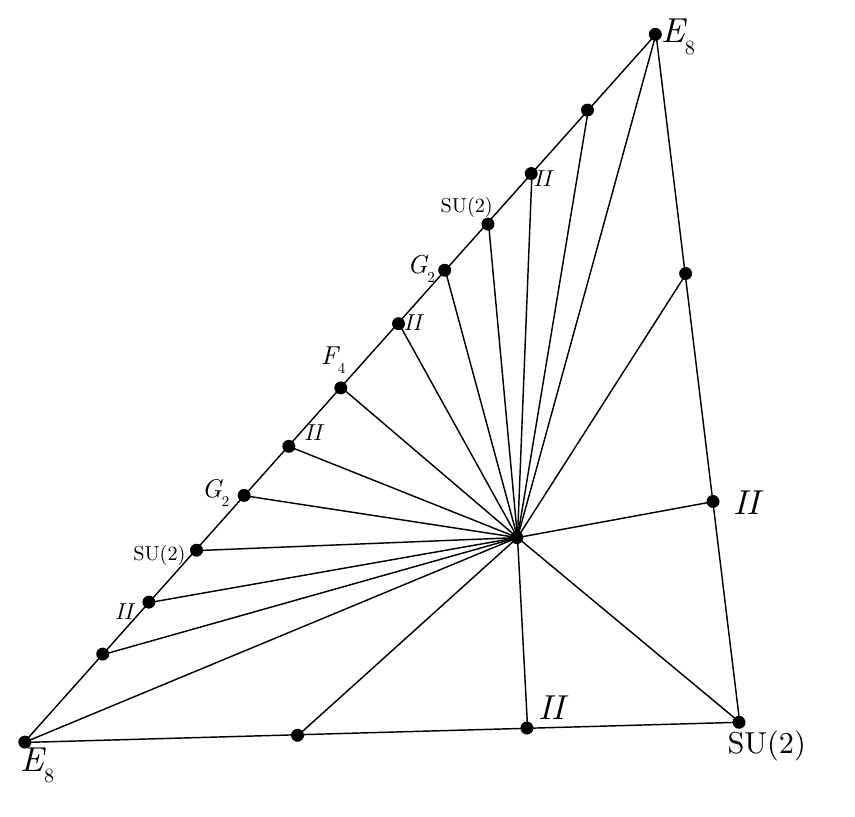
Figure 6 . The fully blown up ( E 8 , E 8 , SU(2))